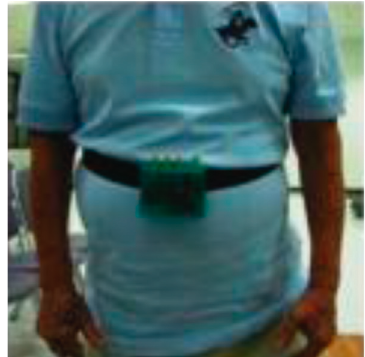
Figure 3: The device was placed on the abdomen and strapped around the waist.